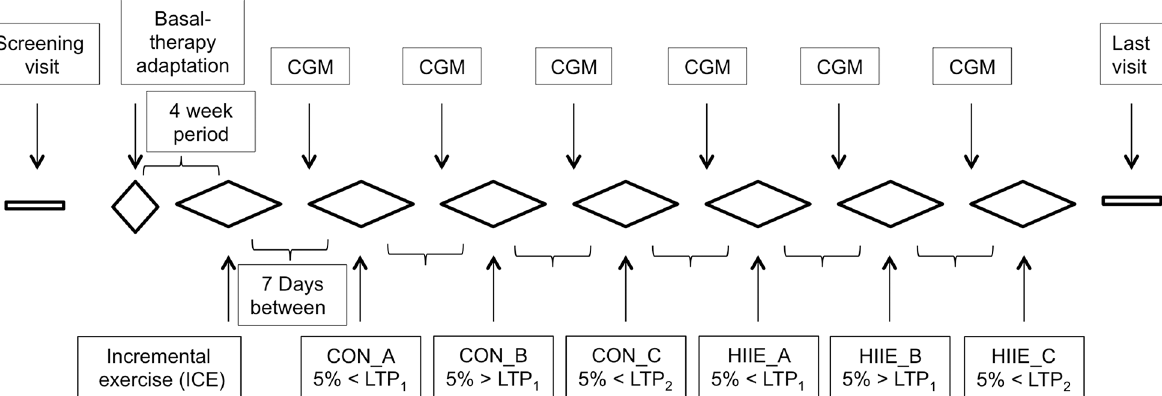
Fig 2. Timeline chart of the study procedure. CGM: Continuous glucose monitoring system, ICE: Incremental exercise, LTP 1 : Lactate turn point 1, LTP 2 : Lactate turn point 2, CON: Moderate continuous exercise, HIIE: short high-intensity interval exercise.